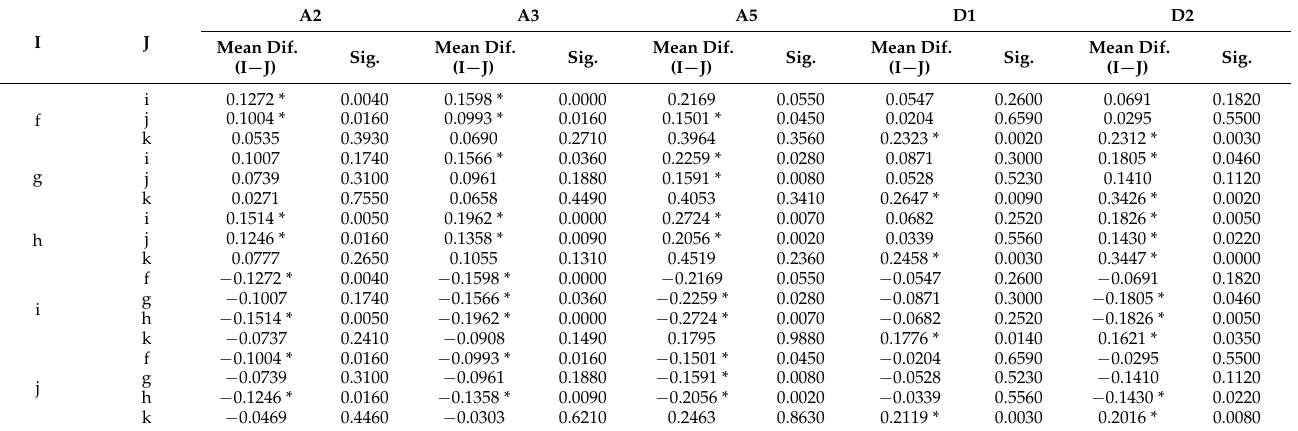
Table 5. Multiple comparison analysis of landscape design indicators of riverside parks of different types (only some important data are displayed here; all data can be found in the Supplementary File in the Supplementary Materials).